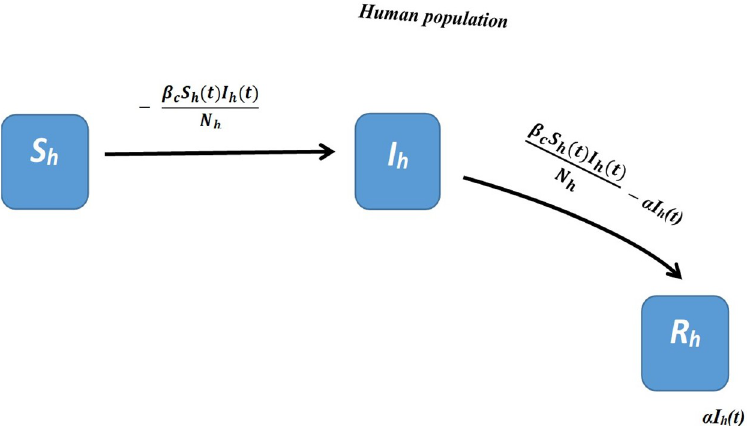
Fig 1. Schematic diagram for the derived SIR deterministic compartmental mathematical model system for bubonic plague disease.